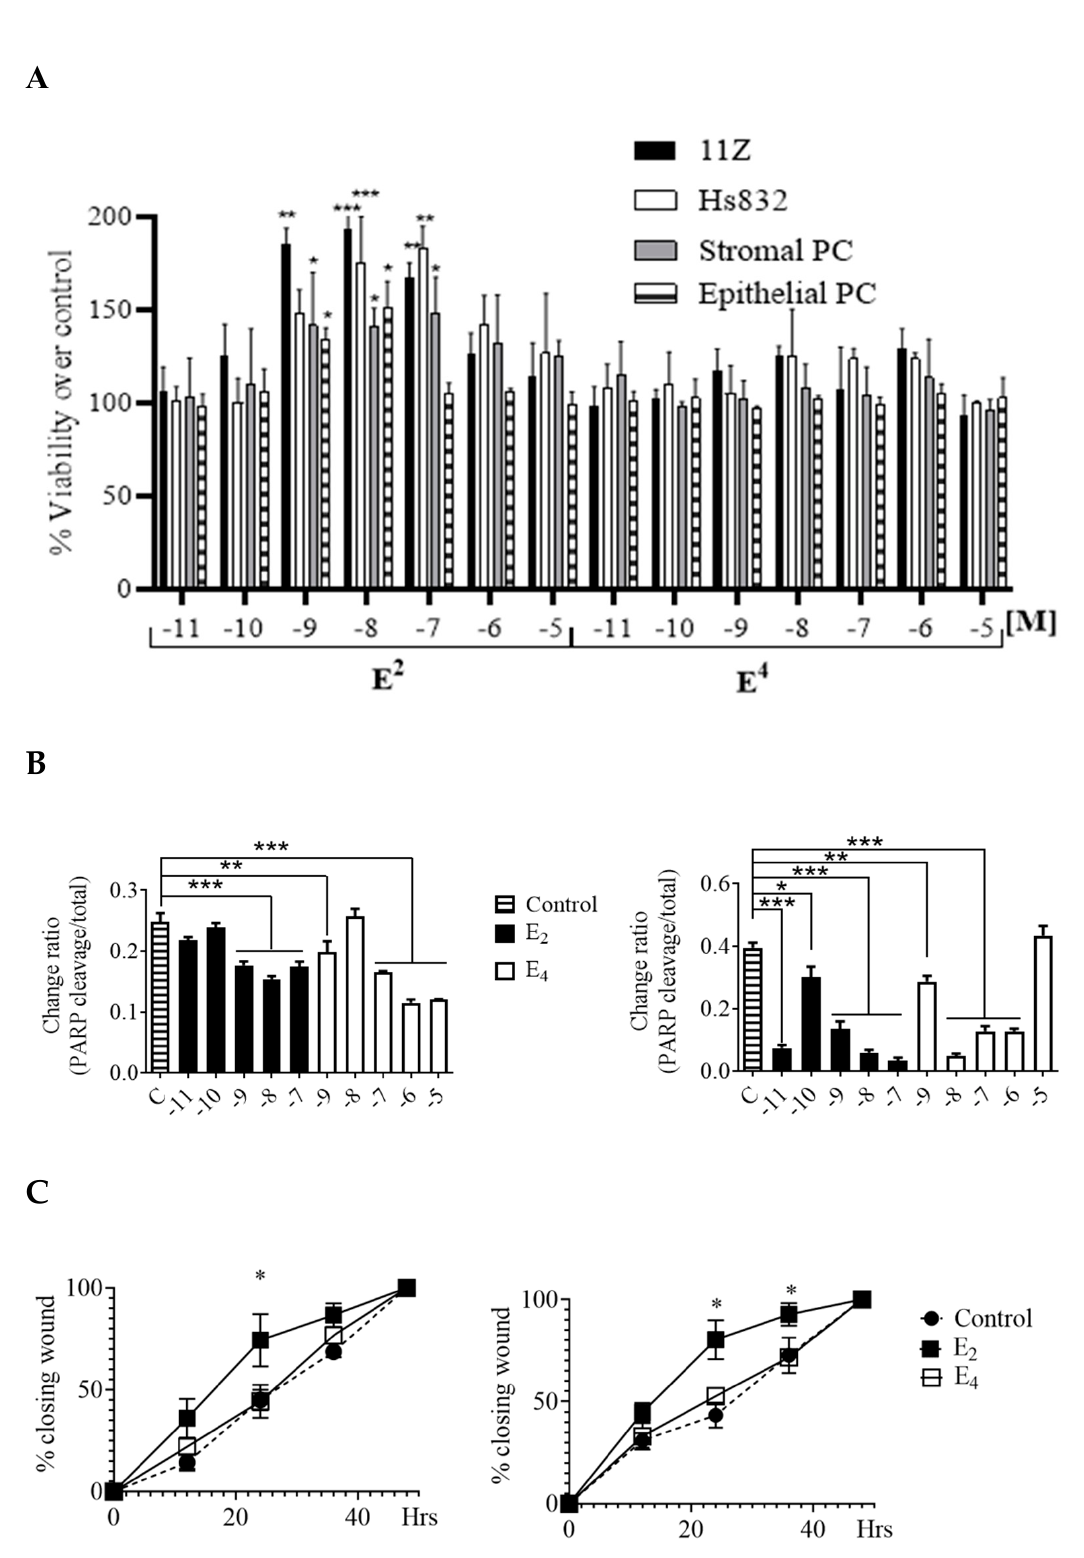
Figure 1. Effect of E4 on cell viability and PARP cleavage levels. ( A ) MTS analysis for endometriotic cell lines (11Z and Hs832) and stromal primary culture from patients. ( B ) Western blot analysis of PARP cleavage levels and ( C ) Scratch assay for 11Z cells (left) and Hs832 (right). Analyzed by one-way ANOVA along with Dunnett’s post hoc test. n = 3; * p < 0.05; ** p < 0.01; *** p < 0.001.